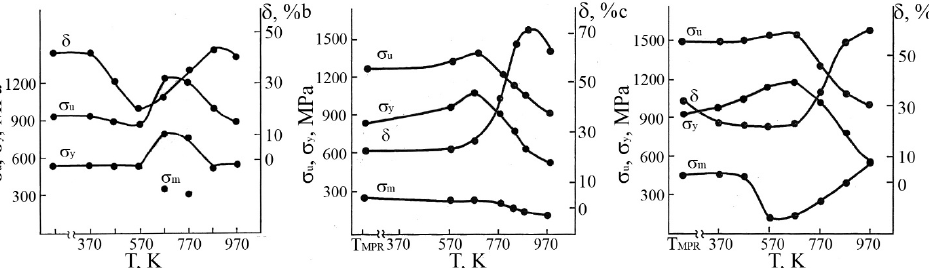
Figure 18. Mechanical properties of the ( a ) quenched Ti 49 Ni 51 alloy, ( b ) PDHT-treated Ti 49.5 Ni 50.5 alloy, and ( c ) PDHT-treated Ti 49 Ni 51 alloy depending on the temperature treatment. Table 5. Mechanical characteristics of the Ti 49 Ni 51 aging alloy.